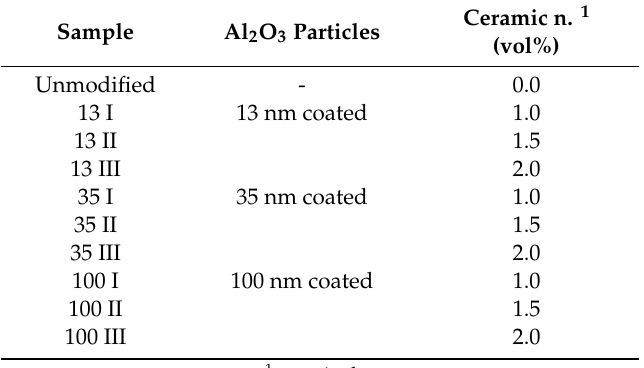
Table 1. Overview of the samples which describe the liquid inks as well as the solidified specimens. The Al 2 O 3 fillers are coated with TODA. Ceramic n. Sample Al 2 O 3 Particles